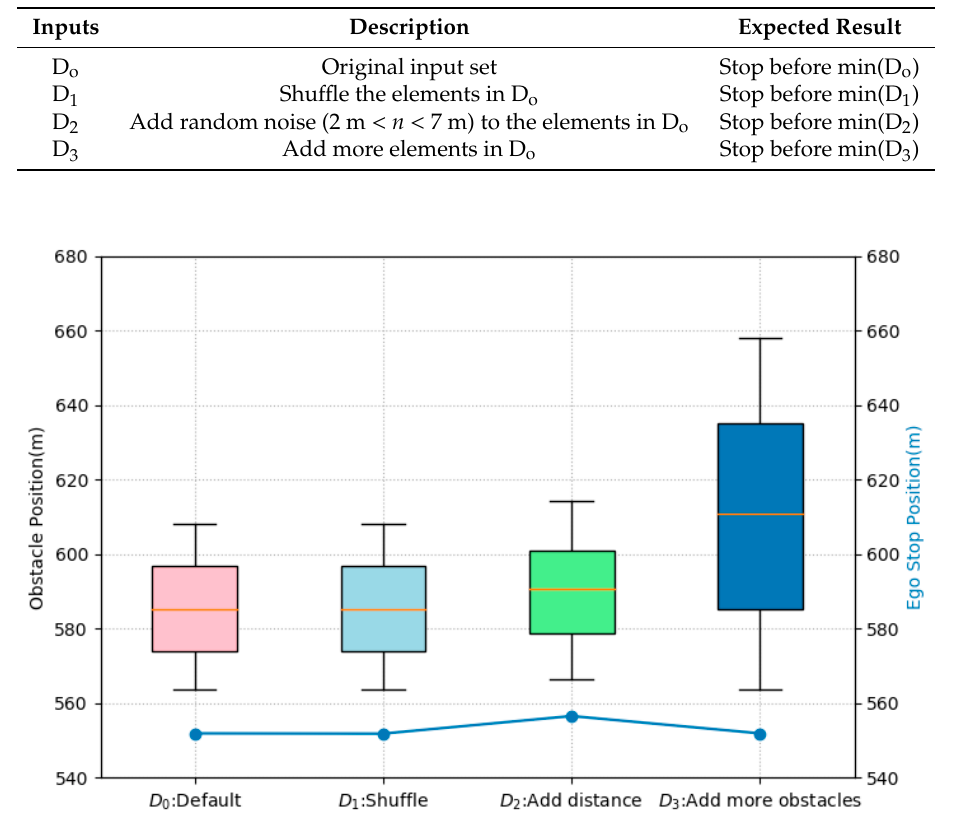
Table 3. Test inputs for stopping regardless of obstacle order.